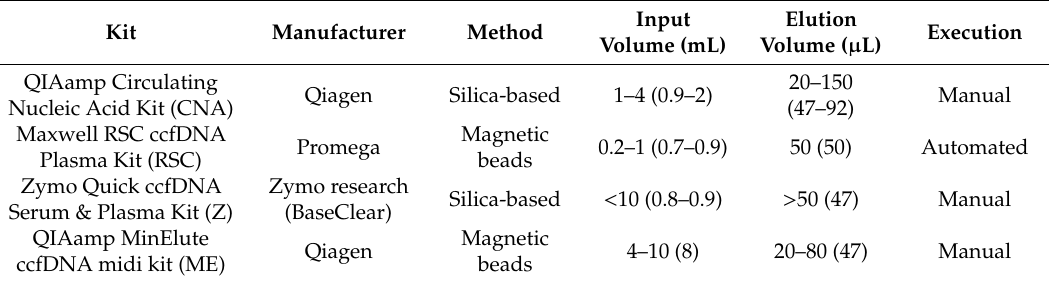
Table 2. Short- and medium-sized fragment percentages of citrate plasma as measured with the Fragment Analyzer.